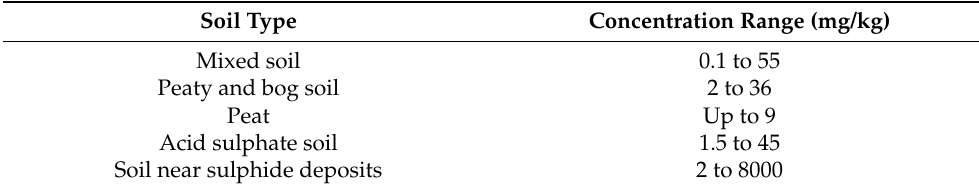
Table 3. Concentration range of As in different types of soil